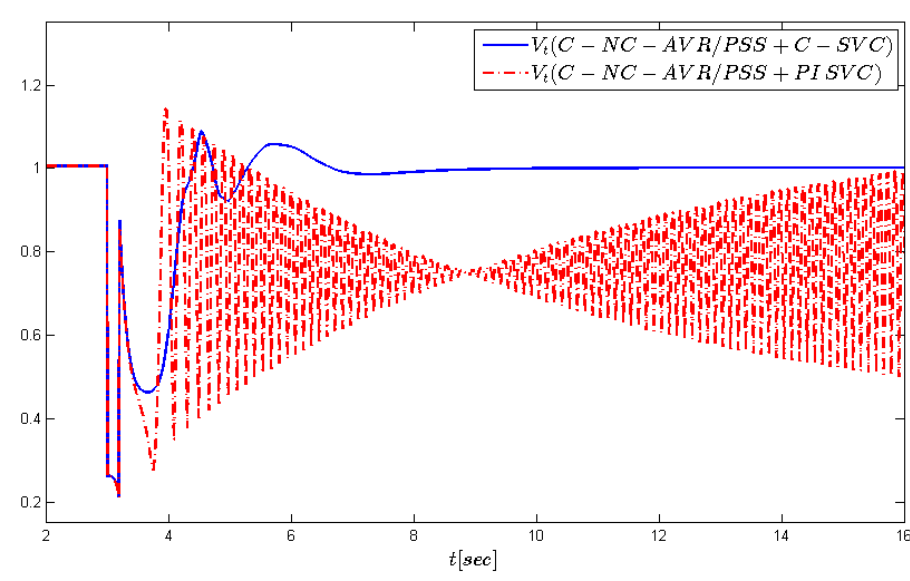
Figure 9. Generator terminal voltage responses (in p.u.).